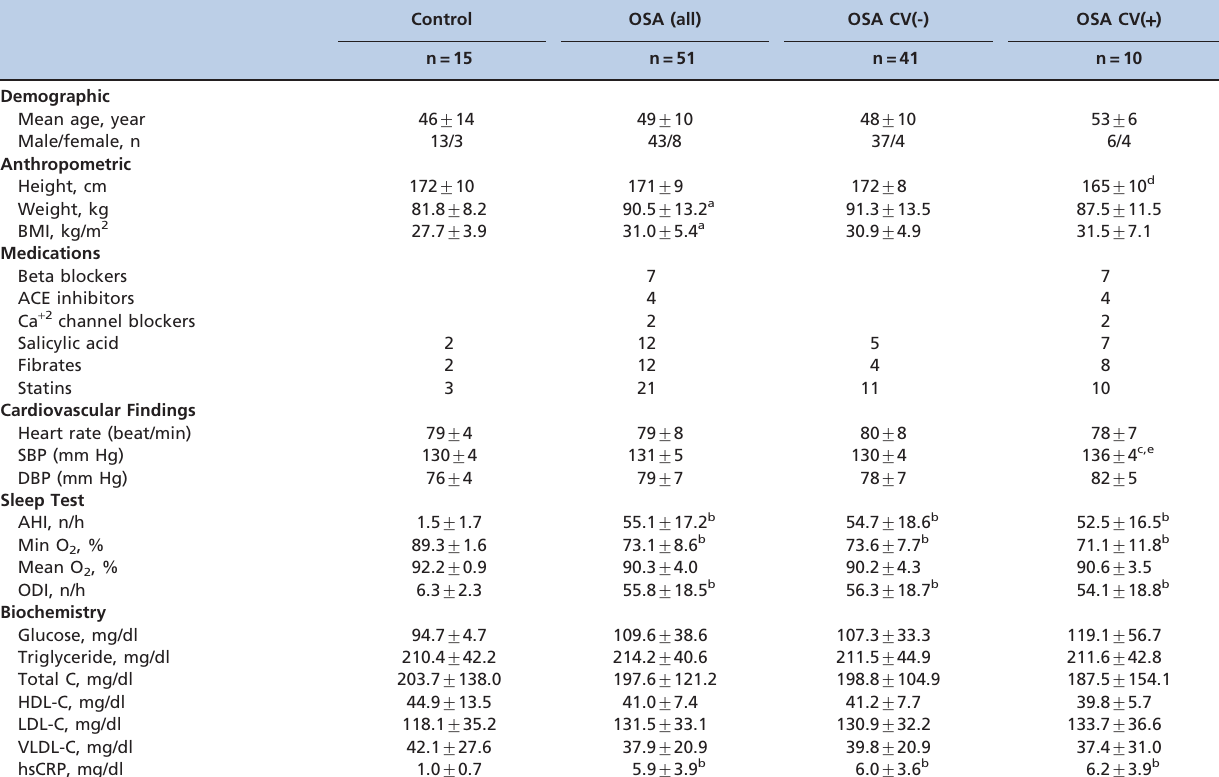
Table 1 - Comparison of demographic, anthropometric, polysomnographic, and biochemical parameters between controls and obstructive sleep apnea syndrome patients.